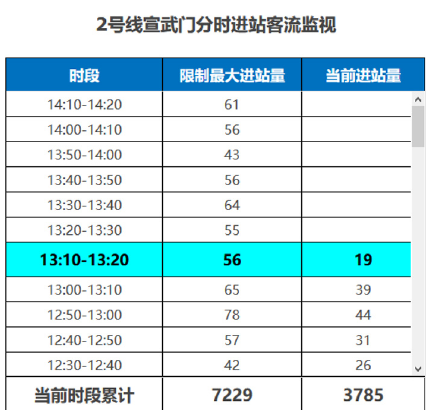
Figure 4. Digital fl ow control